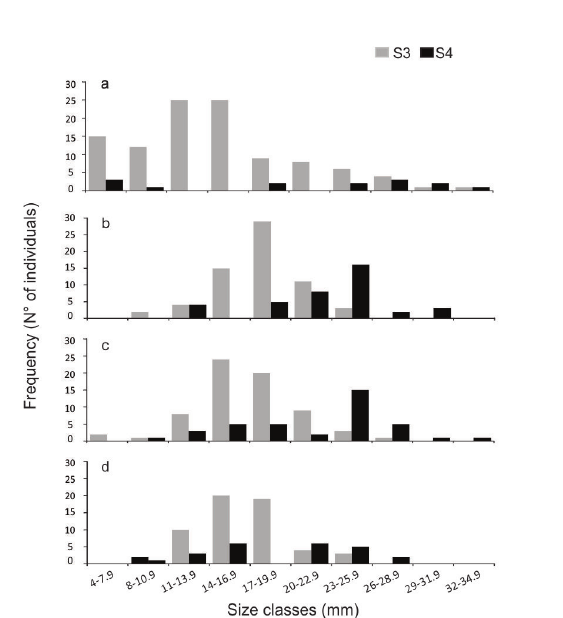
Figure 3 - Size clases of Sinotaia cf quadrata individuals recorded in February ( a ) April ( b ), May ( c ) and June ( d ) at sites 3 and 4 (S3 and S4, respectively).